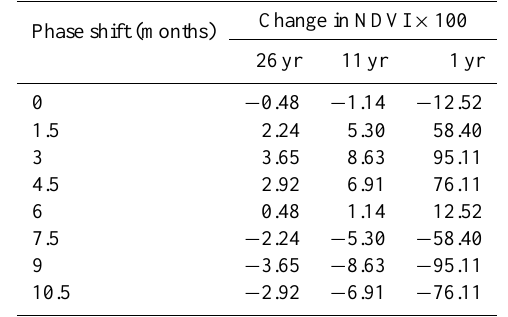
Table 1. Detected changes in NDVI using linear regression on synthetic seasonal data for different starting phases and extents. Change values were calculated as the slope coefficient β (Eq. 1) times the length of the time series and were multiplied by 100 for numerical convenience. The listed lengths of 26yr and 11yr cor- respond to the approximate length of AVHRR and MODIS time series respectively. The applied harmonic model had peak-to-peak amplitude one and therefore change values can be multiplied by the actual amplitude. Due to serial autocorrelation, t-values could not be